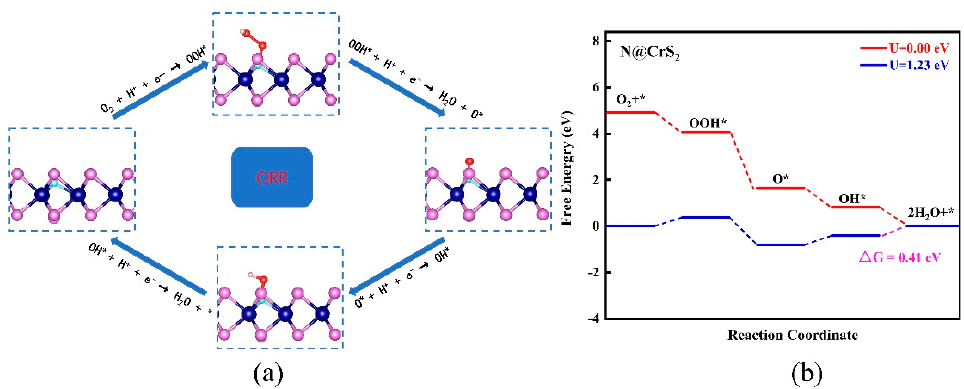
Figure 3. ( a ) The involved reaction pathway and ( b ) the computed free energy diagrams for ORR pathways on the N@CrS 2 monolayer at zero and applied voltages.